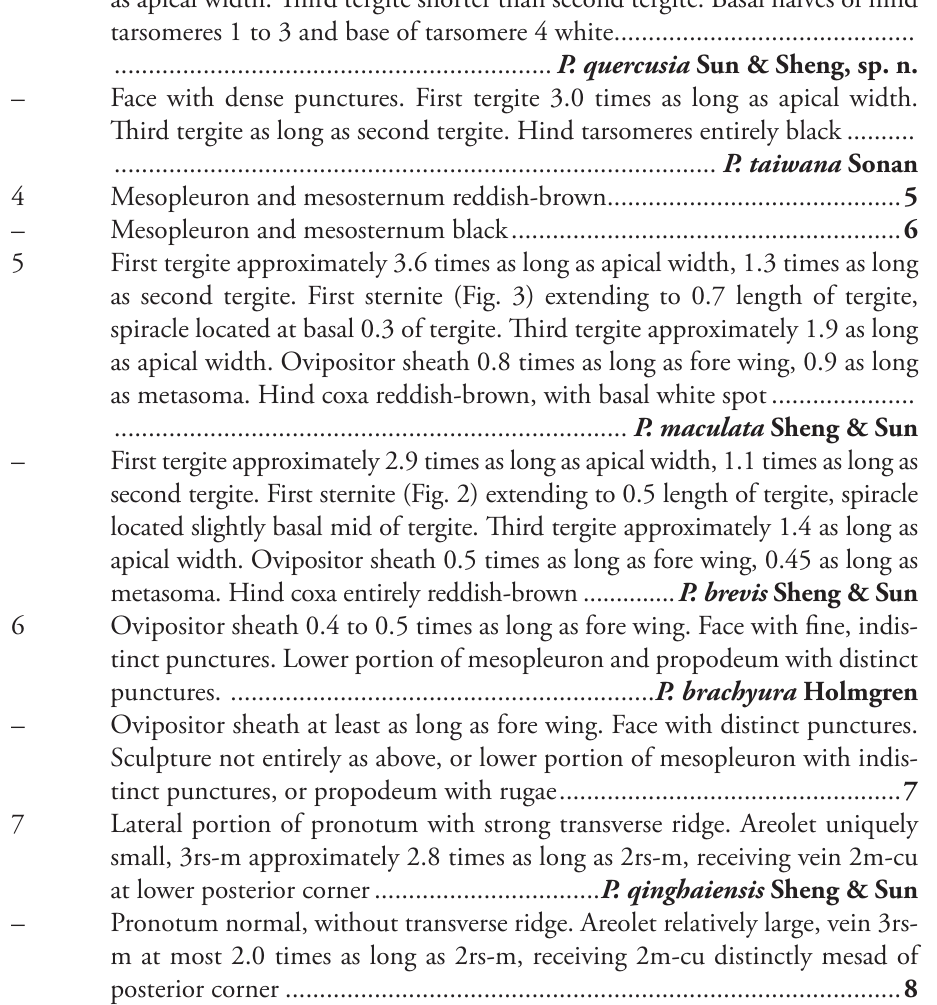
Key to species of Poemenia from China and the Eastern Palaearctic Region 1 First tergite 1.5 times as long as apical width. Second to fourth tergites each with a rhombic depression. Fore wing with large areolet. Large spots on mes- oscutum and metapleuron reddish yellow .......... P. depressa Wang & Gupta – First tergite 2.5 times or more as long as apical width. Second to fourth ter- gites without rhombic depressions. Fore wing without or with relatively small areolet. Mesoscutum and metapleuron entirely black .................................. 2 2 Fore wing without areolet ........................................................................... 3 – Fore wing with areolet ................................................................................ 4 3 Face with dense long opalescent hairs (Fig. 8). First tergite 2.7 times as long as apical width. Third tergite shorter than second tergite. Basal halves of hind